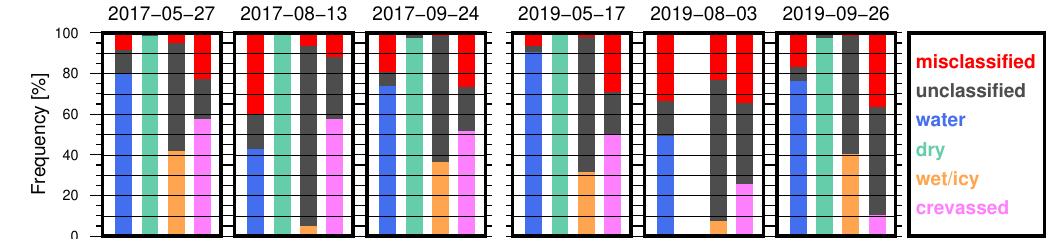
Figure 5. Validation of classification results by test areas (similar to training areas) at six independent epochs. The frequency of correct classification is shown in the color of the respective class; the unclassified fractions of the test areas are shown in dark gray and the misclassified fractions in